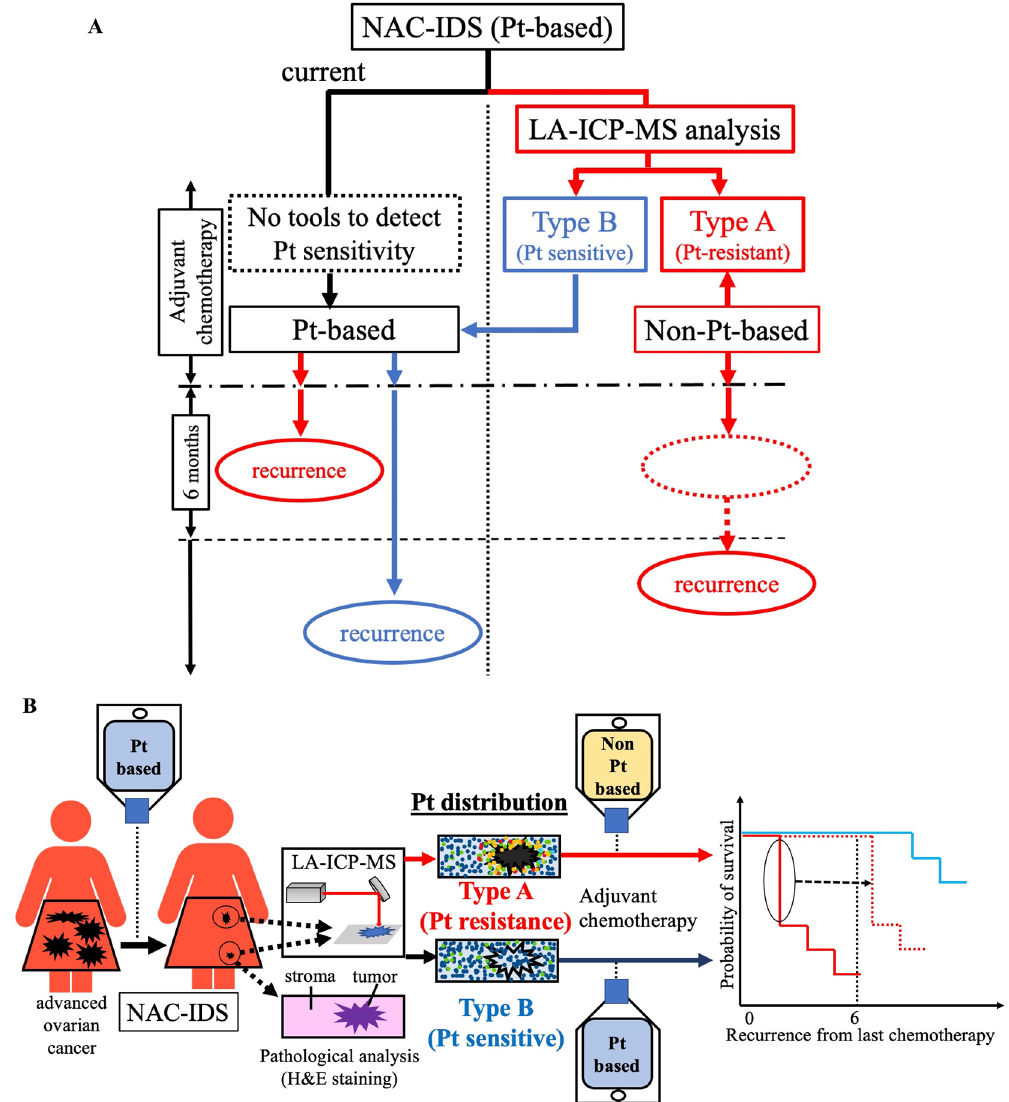
Figure 6. New ovarian cancer treatment strategy using LA-ICP-MS. ( A ) LA-ICP-MS revealed platinum resistance in NAC-IDS samples before recurrence. Since type A patients have a significant worse prognosis when the same platinum-based agents are used in adjuvant chemotherapy, we suggest a change to non- platinum-based adjuvant chemotherapy for patients classified as type A in order to improve their disease progression and prognosis and to decrease the side effects of inefficient platinum-based agents. ( B ) Graphic abstract in this study. In samples from patients with high-grade serous ovarian cancer who have undergone neoadjuvant chemotherapy followed by interval debulking surgery, laser ablation–inductively coupled plasma mass spectrometry (LA-ICP-MS) reveals the two distinct patterns of platinum distribution of the tumor and the adjacent stroma: decreased platinum in the tumor and accumulation in the adjacent stroma (named ‘type A’ herein), which is related to platinum resistance with short latency to recurrence and poor prognosis compared to the type B in which the platinum distribution is similar in the tumor and stromaBy using this technique at the time of surgery, we can select appropriate chemotherapy for each patient, which can improve their